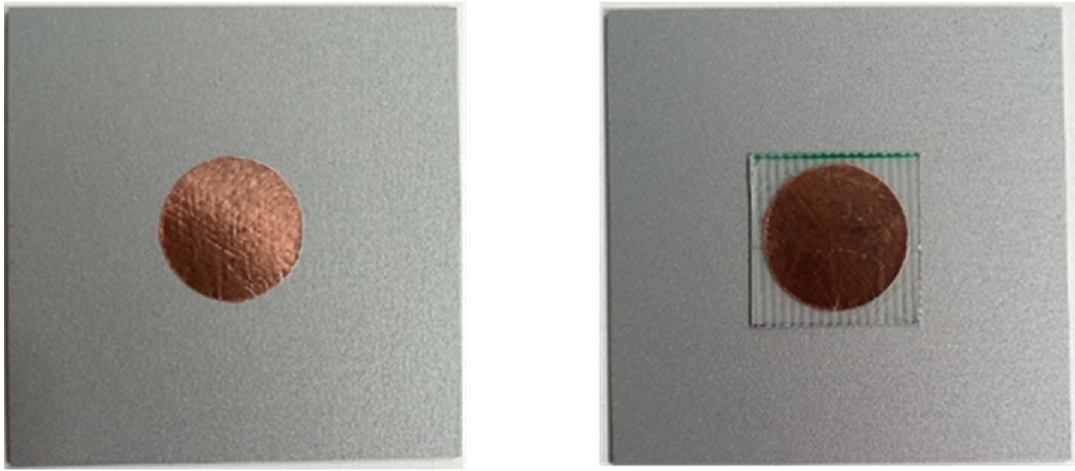
Figure 7. The manufactured Chipless RFID Tag deployed onto the same without ( left ) and with ( right ) the substrate layer.